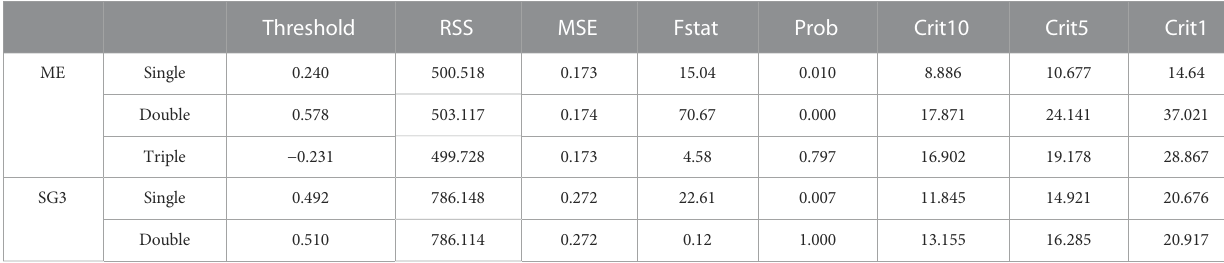
TABLE 8 Threshold value